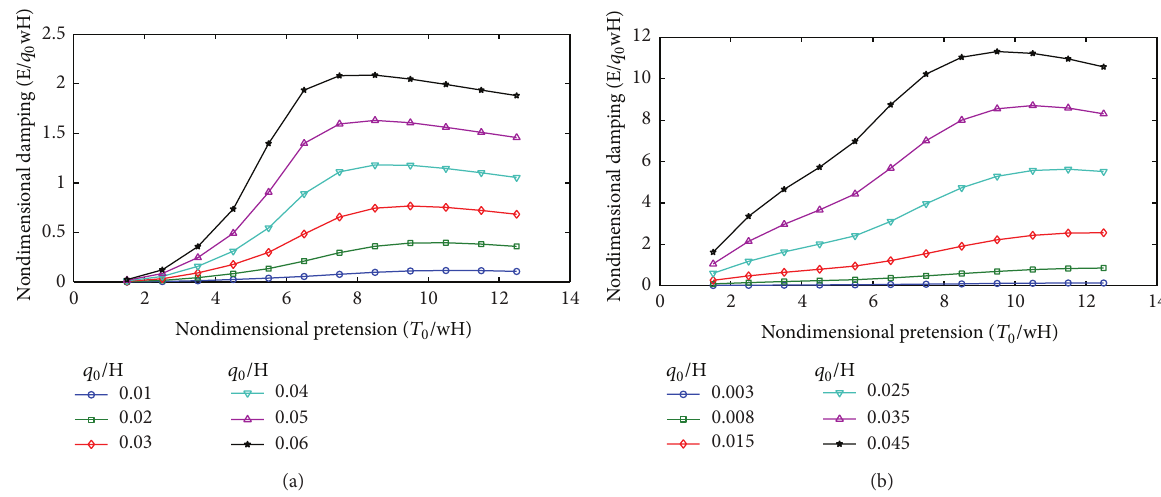
Figure 7: Variation of mooring line damping with excitation amplitude. (a) Horizontal motions. (b) Vertical motions.